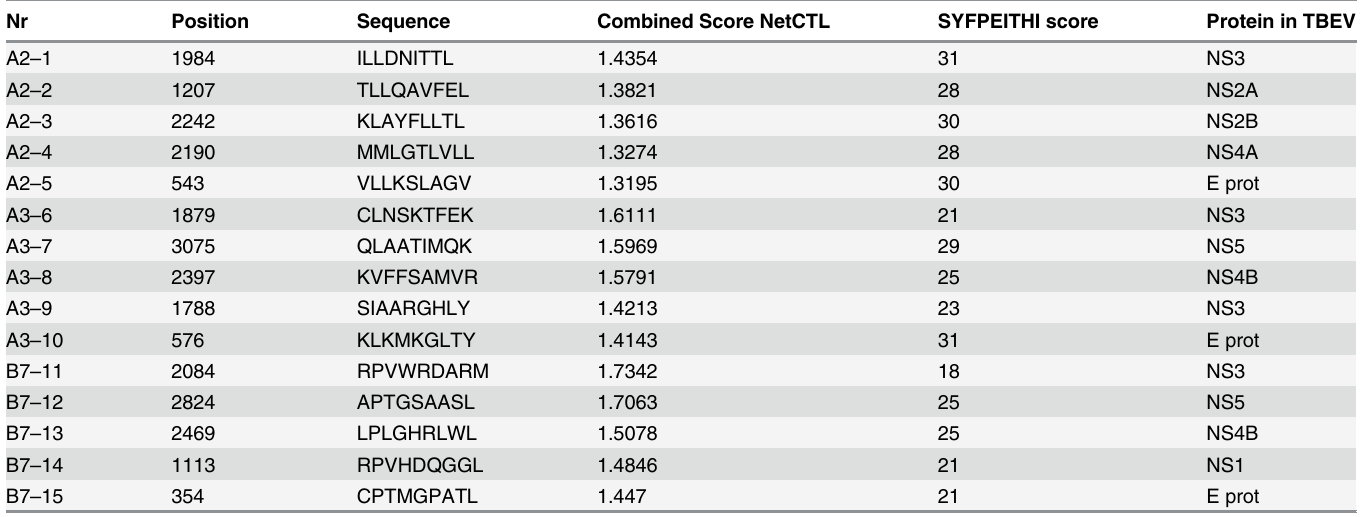
Table 1. TBEV peptides predicted by the NET-CTL